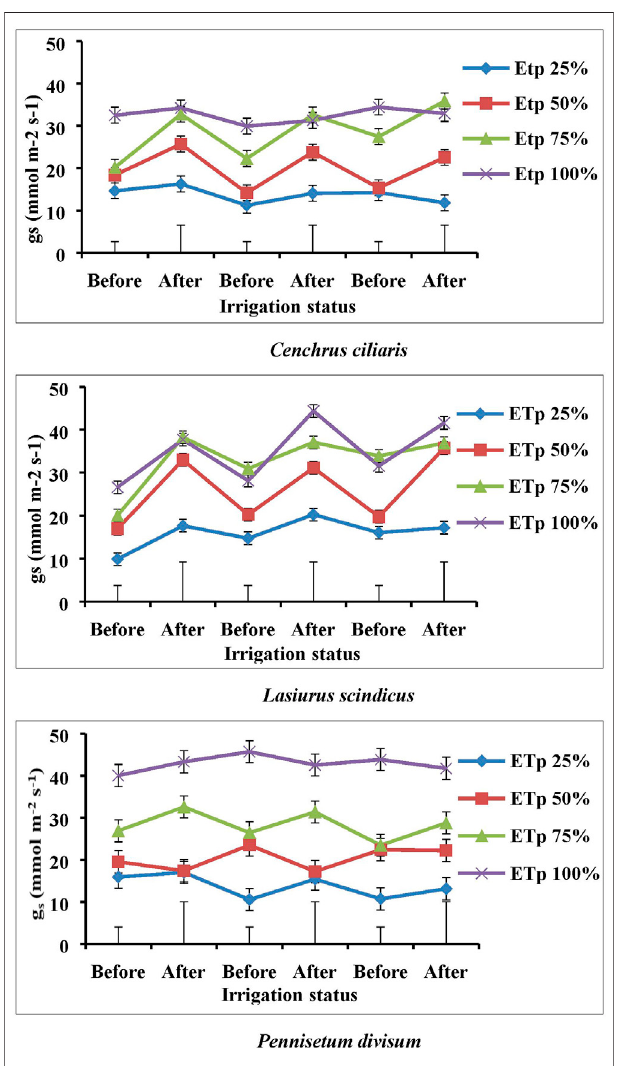
FIGURE 3 | Effect of different irrigation regimes on the stomatal conductance (g s ) of Cenchrus ciliaris , Lasiurus scindicus , and Pennisetum divisum . Bars ( ┬ ) represent the Least Signi fi cant Difference values (LSD) for comparisons between treatments at p < 0.001 and p < 0.05. d. f = 95.